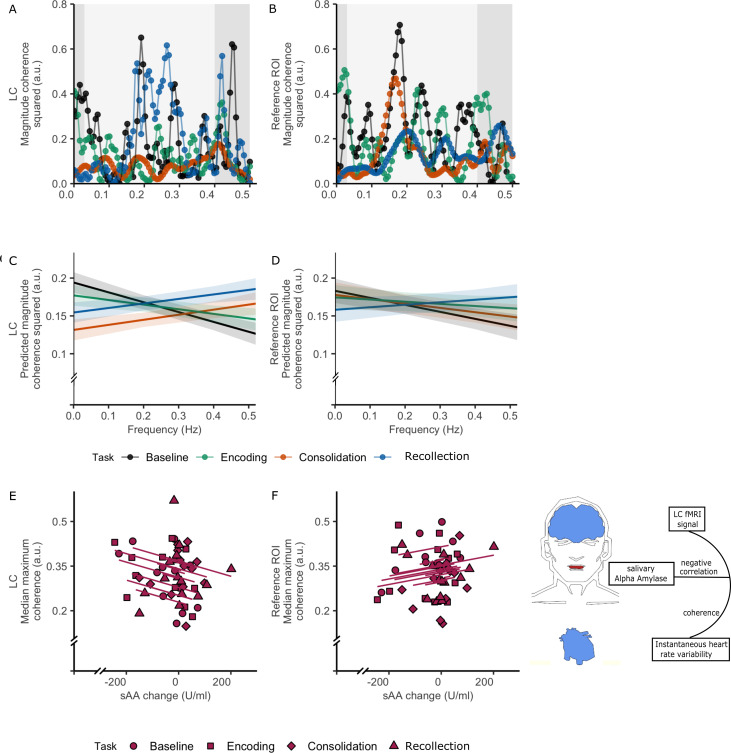
Coherence between LC and HRV across the task stages.(A) LC coherence magnitude squared plotted against frequency for each task stage for a single participant. The high-frequency HRV band is depicted in a lighter shade. (B) Reference ROI-HRV coherence magnitude squared for the same participant. (C) The association between frequency and the predicted magnitude squared coherence between the LC and HRV across the various task stages (based on linear mixed effects models, N = 24 (7920 observations), p-values for all comparisons are provided in Supplementary file 7). Shaded regions in C and D show the 95% confidence intervals. (E) Repeated correlations between LC-HRV coherence and ΔsAA (Rrm(df)=−0.383 (34), p-value=0.021). (F) Reference ROI-HRV coherence and sAA change levels (not significant, Rrm(df)=0.218 (34), p-value=0.201).Figure 5—source data 1.Coherence between locus coeruleus BOLD and HRV.Individual coherence values between locus coeruleus or reference BOLD and HRV per frequency are provided for each task stage in the paradigm. For panel E and F, the individual ΔsAA and median of maximum coherence between locus coeruleus or reference BOLD and HRV are provided.